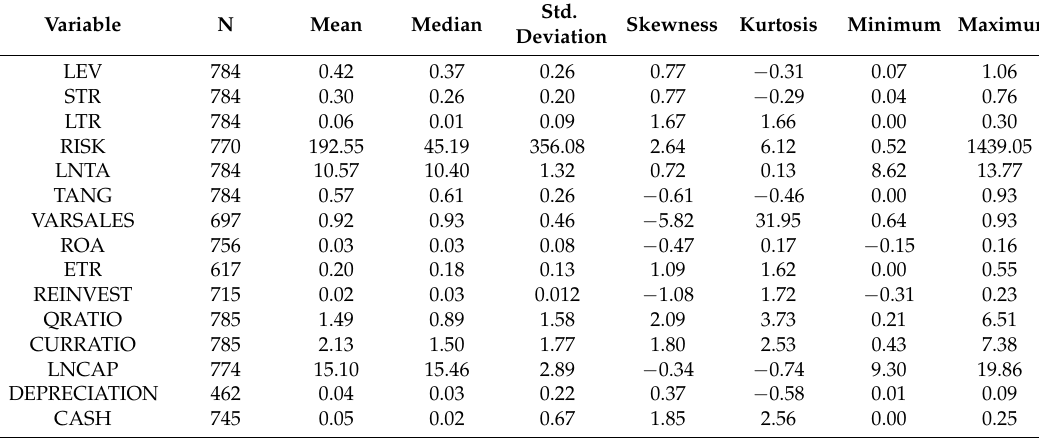
Table 6. Descriptive